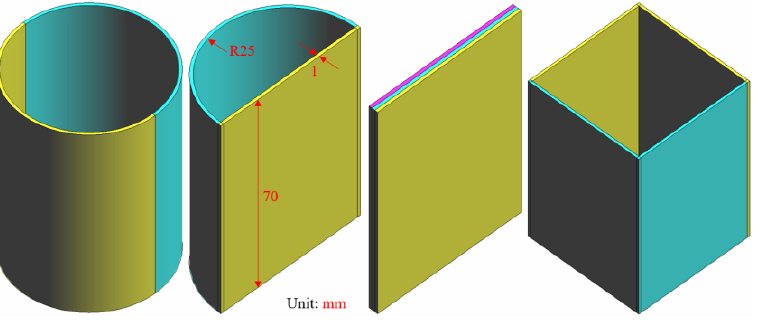
Figure 17. Component integration for improving the SLM process of different open thin-wall geometries. Each color corresponds to one part.